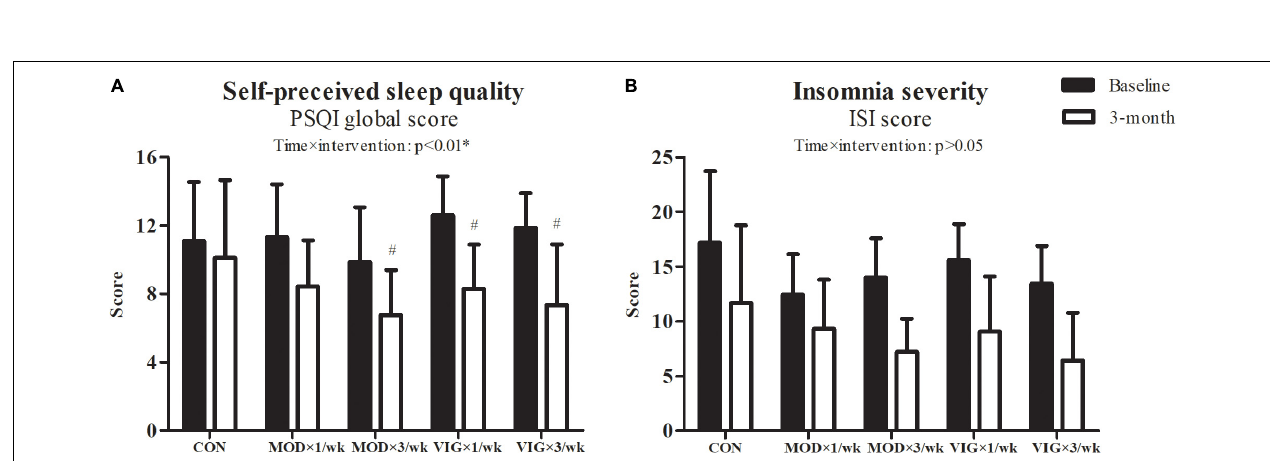
FIGURE 3 | Self-perceived sleep quality (A) and insomnia severity (B) were examined at baseline and after the 12-week intervention. CON (attention CON group) = one session of 75 min stretching exercise weekly, VIG × 3/week = three sessions of 25 min vigorous-intensity (6.5 METs) walking exercise weekly, MOD × 3/week = three sessions of 50 min moderate-intensity (3.25 METs) walking exercise weekly, VIG × 1/week = one session of 75 min vigorous-intensity (6.5 METs) walking exercise weekly, MOD × 1/week = one session of 150 min vigorous-intensity (3.25 METs) walking exercise weekly. # Significantly different from CON at the same time